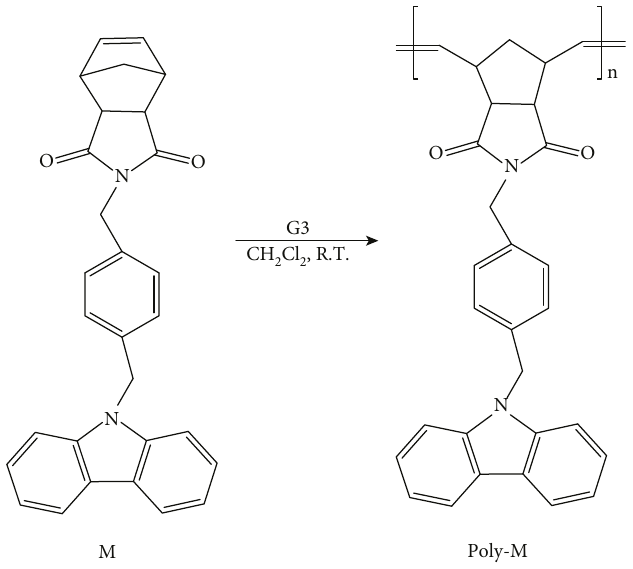
Figure 3: Polymerization scheme.